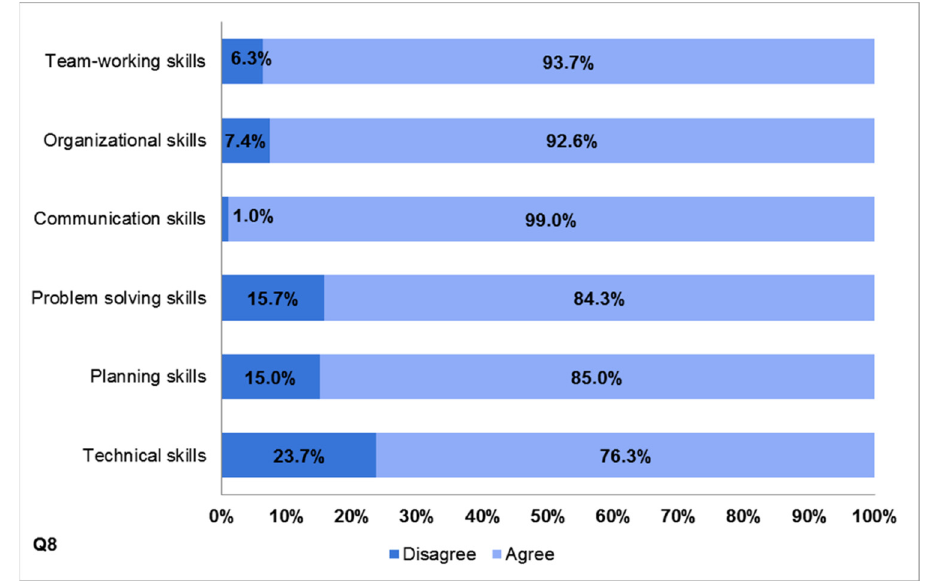
Figure 4. Bar chart displaying results of self-assessment in skills development (Q8).